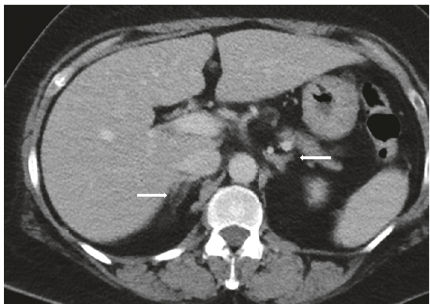
Figure 5: At the end of treatment. Posttreatment PET-CT scan showing a borderline enlarged left supraclavicular lymph node (white arrow) with moderate to intense FDG activity (SUVmax